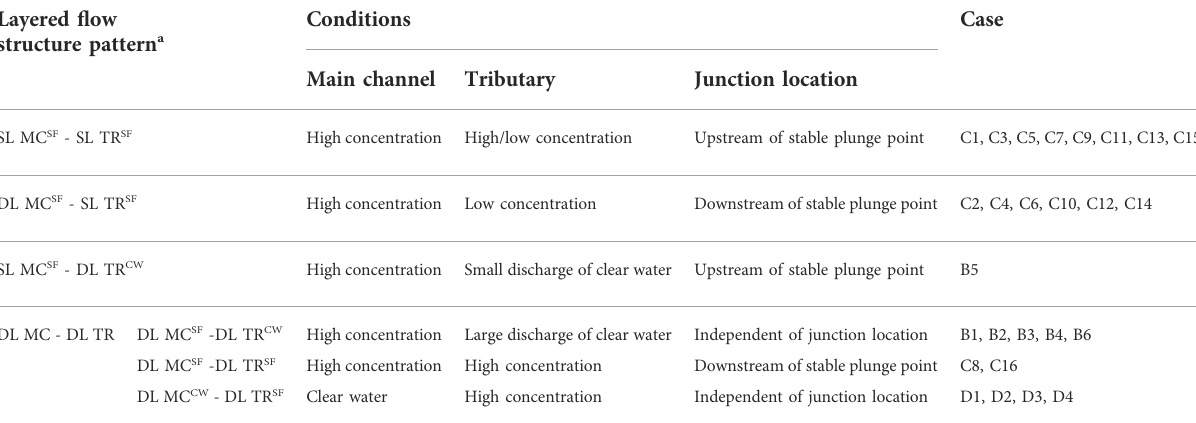
TABLE 3 Stable vertically layered fl ow structure patterns at idealized, laboratory-scale con fl uences. Layered fl ow structure pattern